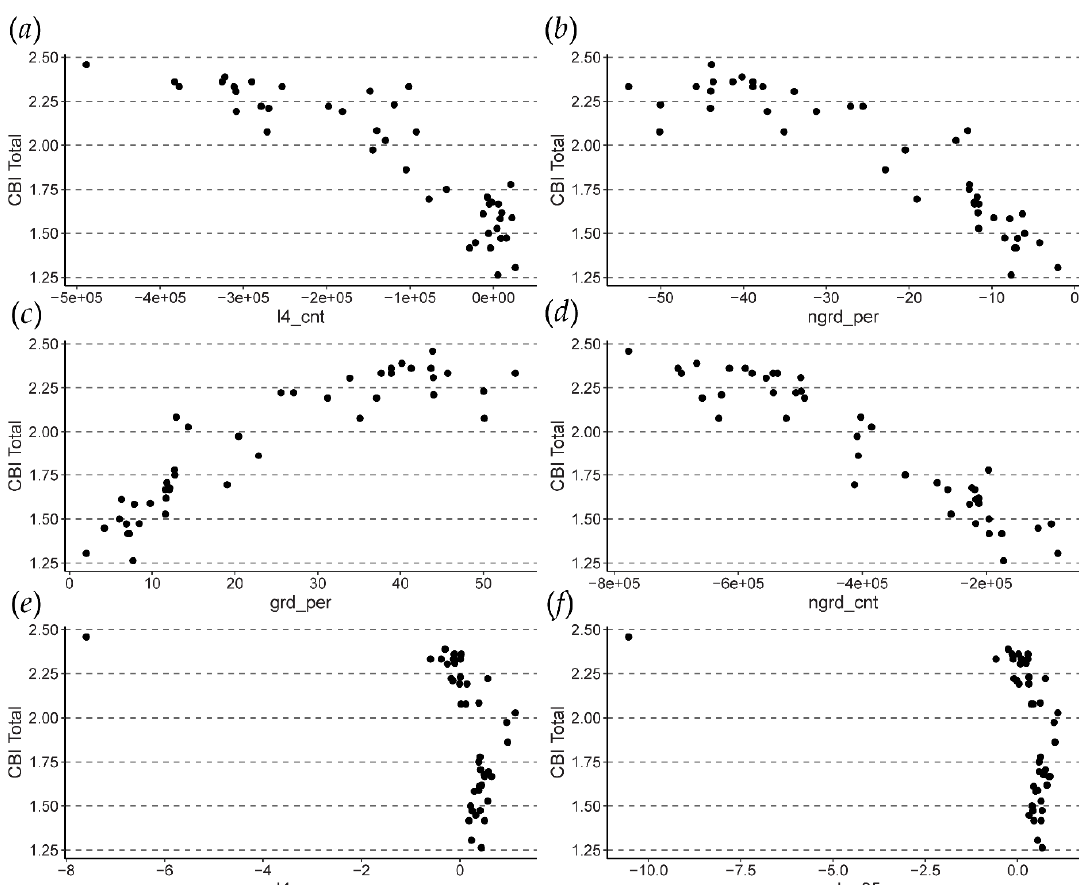
Figure 4. Correlation between total plot CBI and the six variables, which were documented to be of highest importance based on the Boruta method. These variables included ( a ) l4_cnt, ( b ) ngrd_per, ( c ) grd_per, ( d ) ngrd_cnt, ( e ) l4_mn, and ( f ) ngrd_p95.